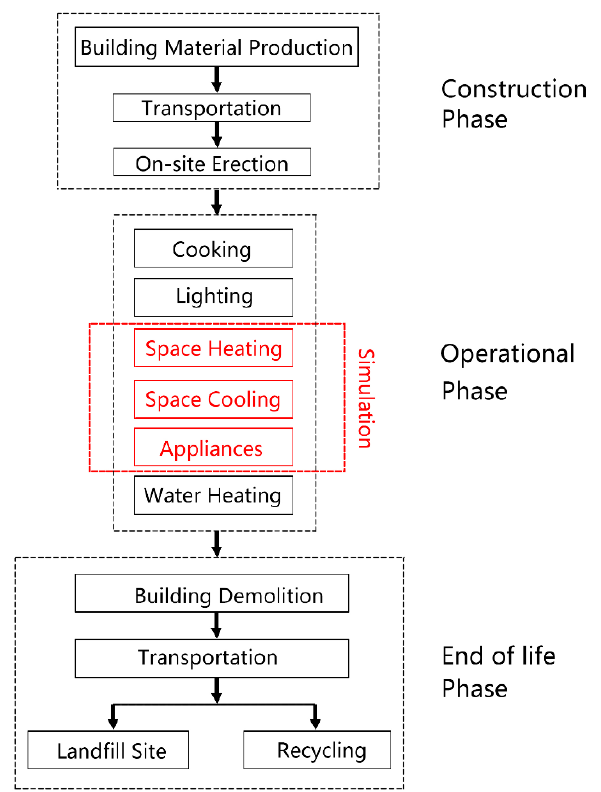
Fig. 3. A flowchart for a sustainable building from construction phase leading to operational phase to end phase of sustainable building ( Haibo et al., 2017)